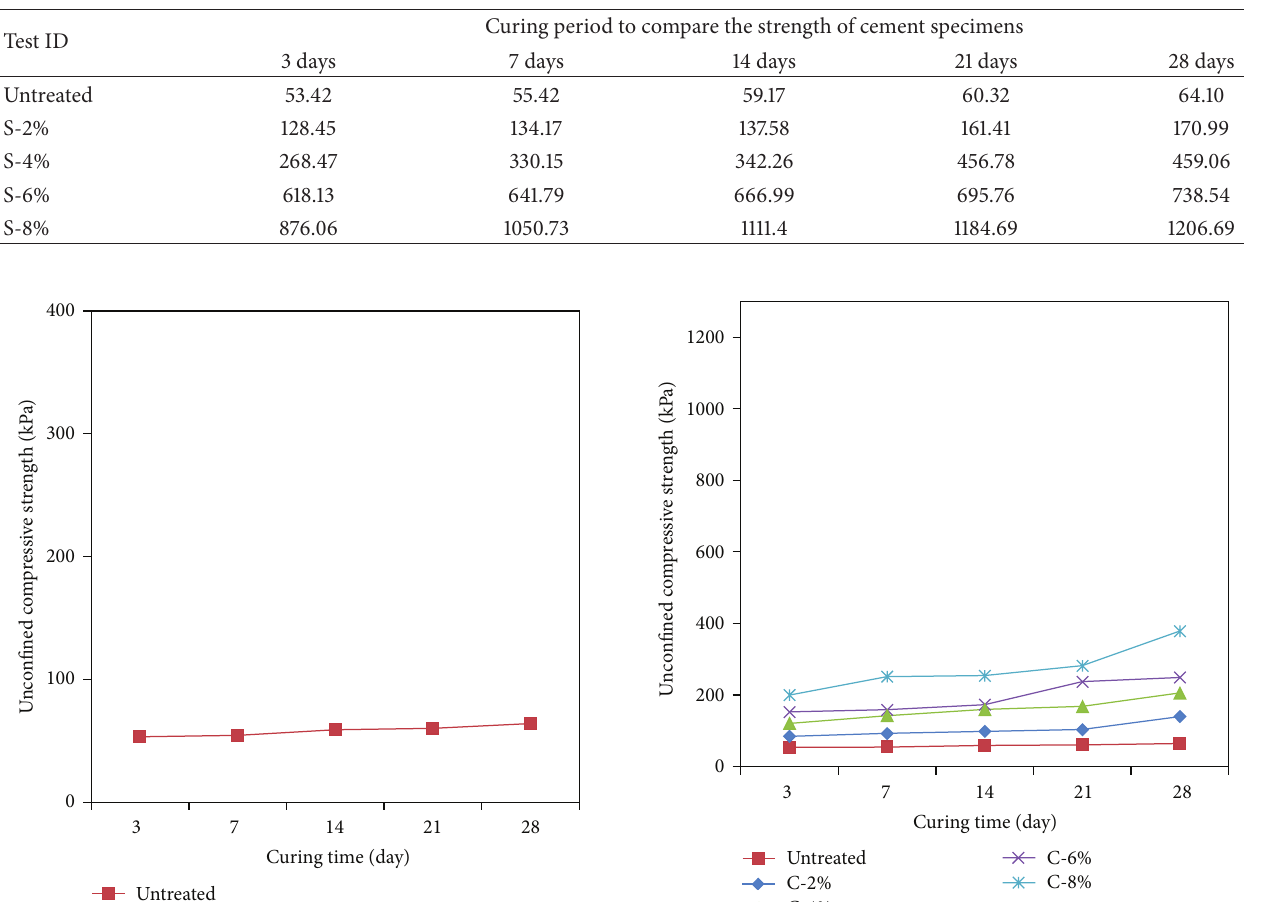
Table 4: Curing period to compare the strength of cement specimens (unit: kPa).